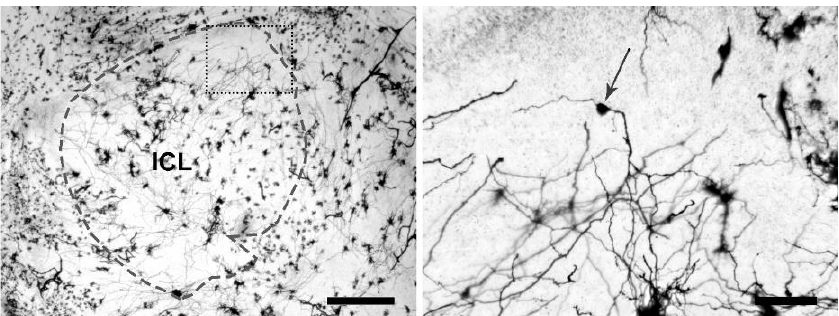
Figure 3. Golgi-Cox Staining in Light Microscopy. Left image shows the ICL of a male Silver eel’s OB (grey dotted line) (scale bar = 250 µm). Right image shows a magnification of the rectangular field in the left image (black dotted line), where a subtype IIIb GC (somata indicated by the grey arrow) is located (scale bar = 50 µm).